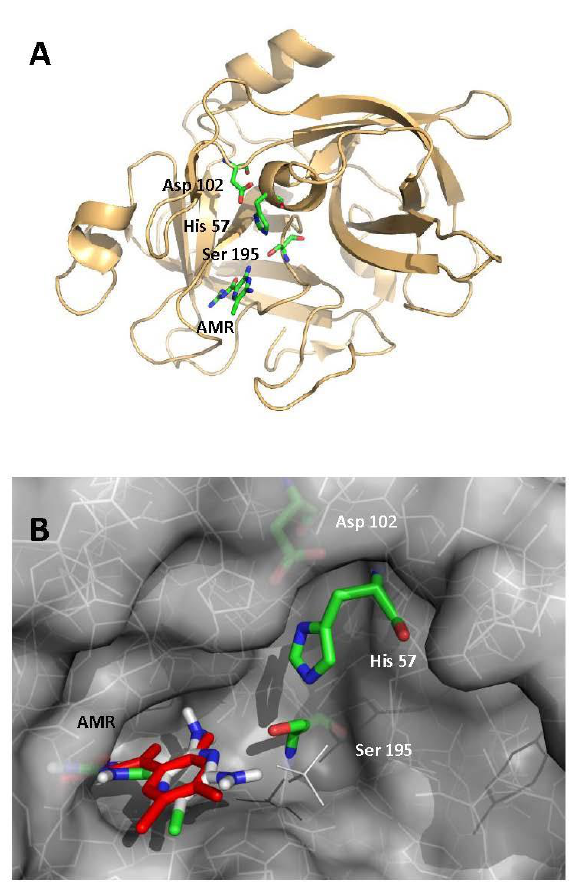
Fig. 1. A: carton model of urokinase (1F5L), amino acids of cat- alytic triad (His57, Asp 102 and Ser 195) are shown as sticks model and colored: carbon in green, oxygen in red, nitrogen in blue. B: surface of uPA is shown in semitransparent gray, amilorides po- sition in specificity pocket are shown as stick model and colored: amiloride from crystallographic structure in red, best model calcu- lated by Vina Autodock colored as amino acids. Only hydrogens of amiloride calculated by Vina Autodock are shown for clarity.